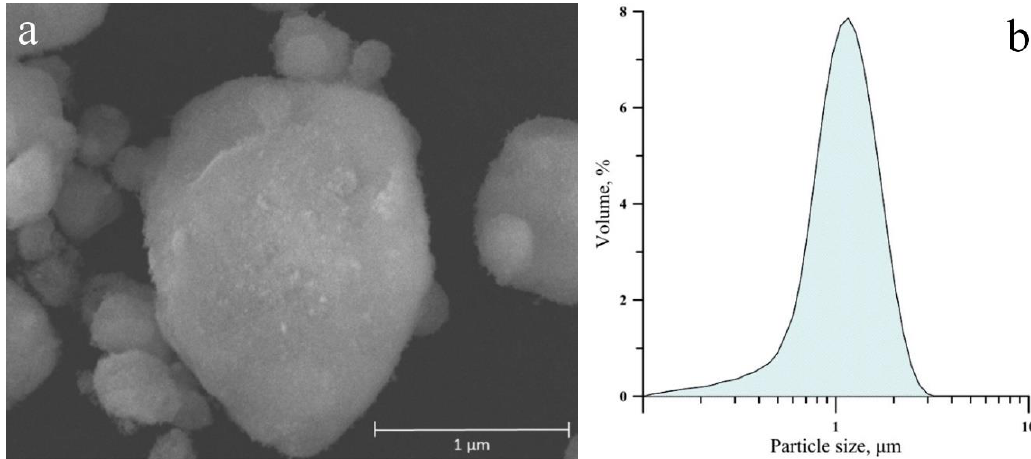
Figure 3. ( a ) An SEM image of the Al 2 O 3 powder and ( b ) a histogram of the particle distribution by size.